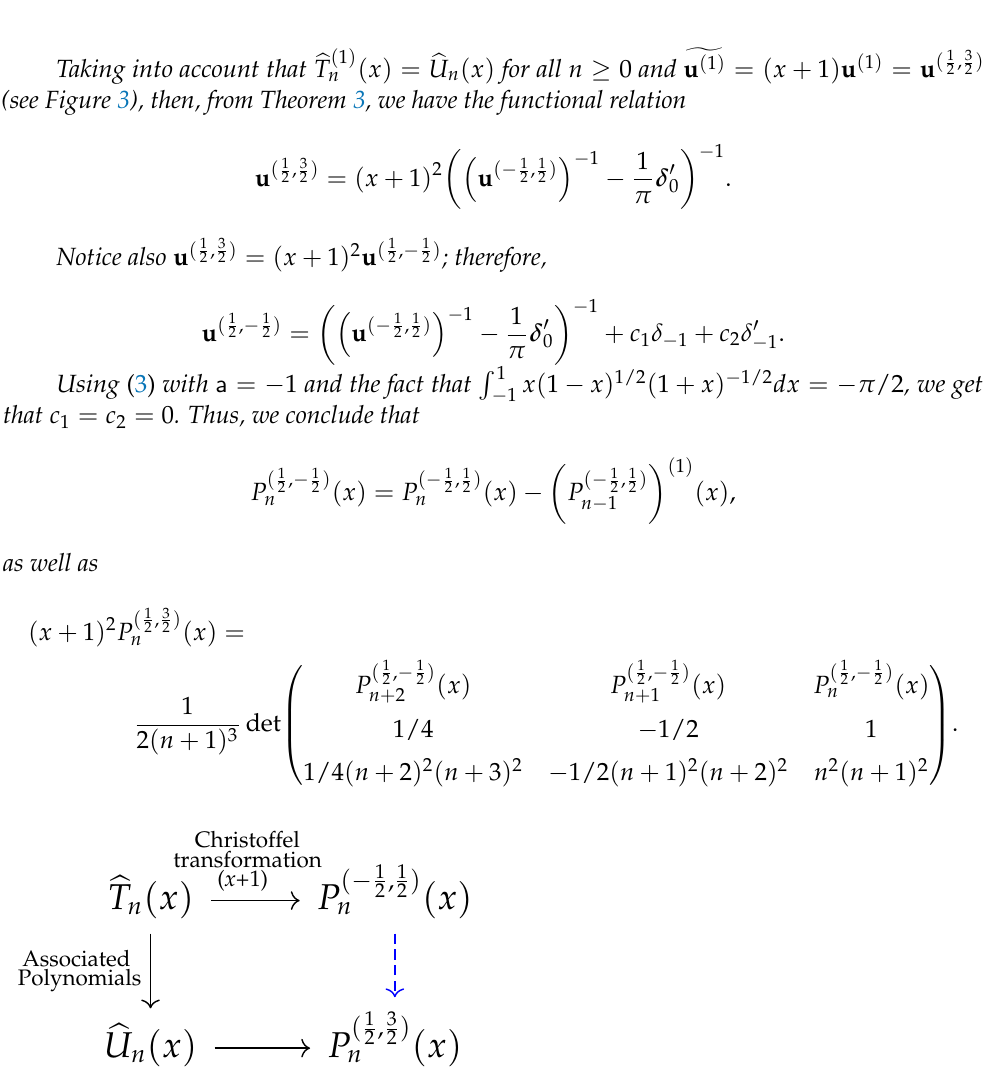
Figure 3. Perturbation of Jacobi polynomials by a canonical Christoffel transformation with ( x + 1 ) . Example 2. Let ( L α + 1